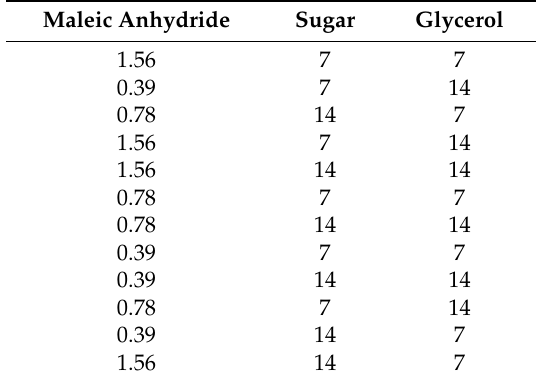
Table 1. Different concentrations ( w / w %) of maleic anhydride, sugar, and glycerol in the optimization experiment. Citric acid concentration was constant at 1% ( w / v ). Maleic Anhydride Sugar Glycerol 1.56 7 7 0.39 7 14 0.78 14 1.56 1.56